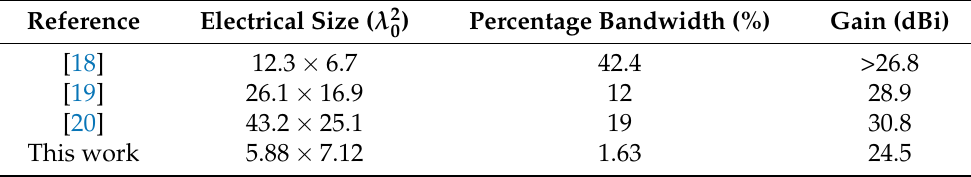
Table 4. Comparison with other similar state of the art